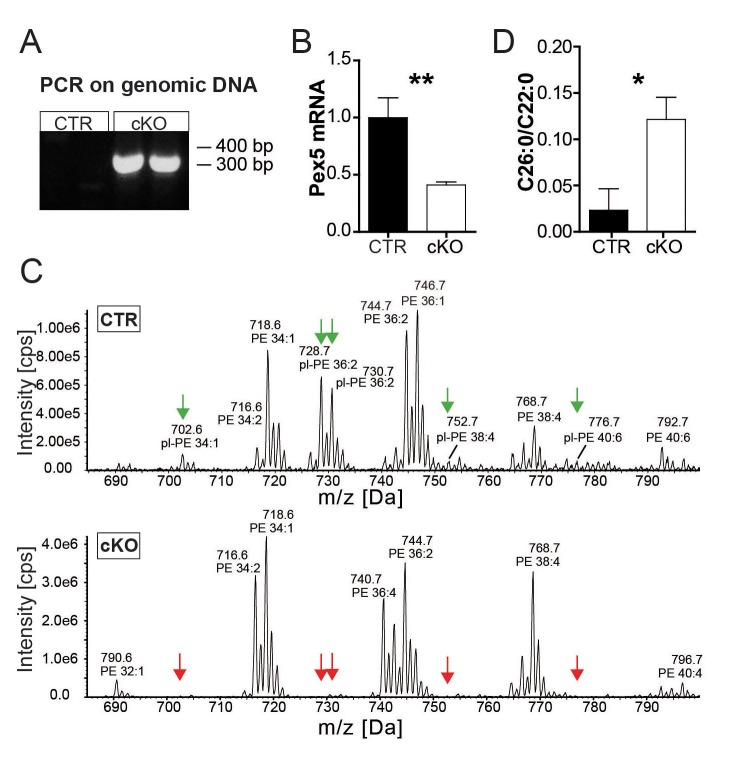
Successful PEX5 ablation causes peroxisomal dysfunction.(A) PCR on genomic tail DNA using primers specifically generating a 300 bp amplicon after Cre-mediated excision of Pex5-floxed exons 11–14. (B) qRT-PCR reveals a 50% (corresponding to the fraction of SC nuclei) reduction of Pex5 mRNA level in mutant nerves (n = 6). (C) Quantitative mass spectrometry of sciatic nerve lysates. Plasmalogens were abundant in a control nerve (top, green arrows at peaks). The same plasmalogens were hardly detectable in a mutant nerve lysate (bottom, red arrows at peaks). (D) Analysis of VLCFA by gas chromatography–mass spectrometry in control and mutant mice. Statistics: means ± s.e.m.; n = 6; *p<0.05; **p<0.01; ***p<0.001, Student’s T-test (B, D).